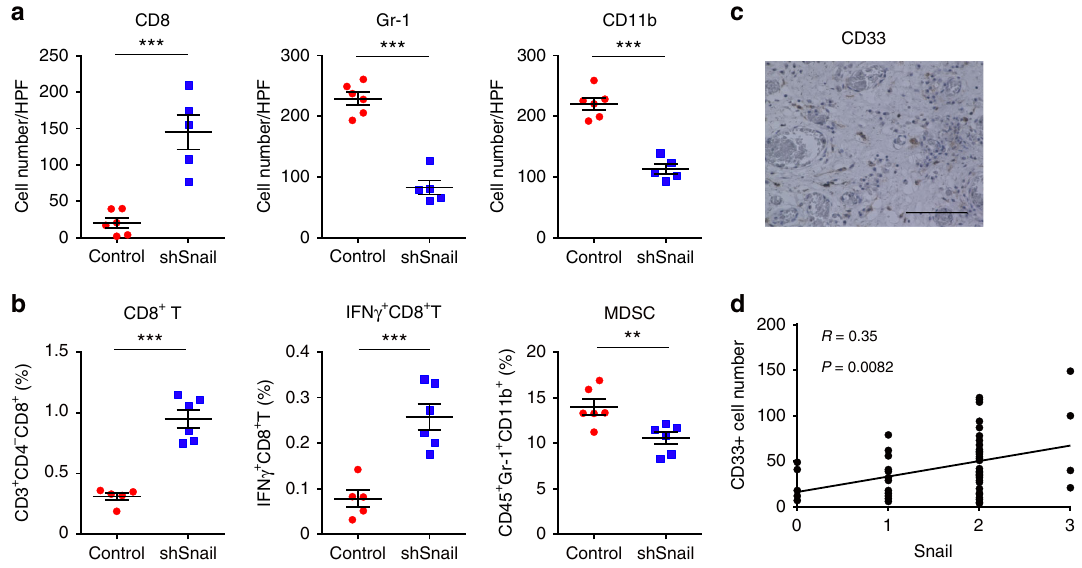
Fig. 3 Snail is associated with increased intratumoral myeloid-derived suppressor cells. a Immunostained cell count in HM-1-control and HM-1-shSnail (sh1) subcutaneous tumors from immunocompetent mice. HPF high power fi eld; n = 5 – 6. CD8 + (left), Gr-1 + (middle), and CD11b + (right). b Flow cytometry of HM-1-control and HM-1-shSnail (sh1) subcutaneous tumors from immunocompetent mice. The percentage of positive cells is plotted; n = 6. CD8 + (left; CD3 + CD4 − CD8 + ), intracellular IFN γ (middle; IFN γ CD3 + CD8 + ), and MDSC (right; CD45 + Gr-1 + CD11b + ). c Representative image showing CD33 expression (a marker of human MDSC) in peritoneal dissemination of human high-grade serous ovarian cancer (HGSOC). Scale bar, 100 μ m. d Correlation between in fi ltration of CD33 + cells and Snail expression in corresponding disseminated tumors in the omentum ( R = 0.35, P = 0.0082) of HGSOC; n = 56; Pearson ’ s product-moment correlation analysis. * P < 0.05, ** P < 0.01, and *** P < 0.001 (unpaired t -test in a and b ). Averaged data are presented as the mean ± + signi fi cant correlation with the number of CD33 cells ( P = 0.0082, Pearson ’ s product-moment correlation analysis) (Fig. 3d).